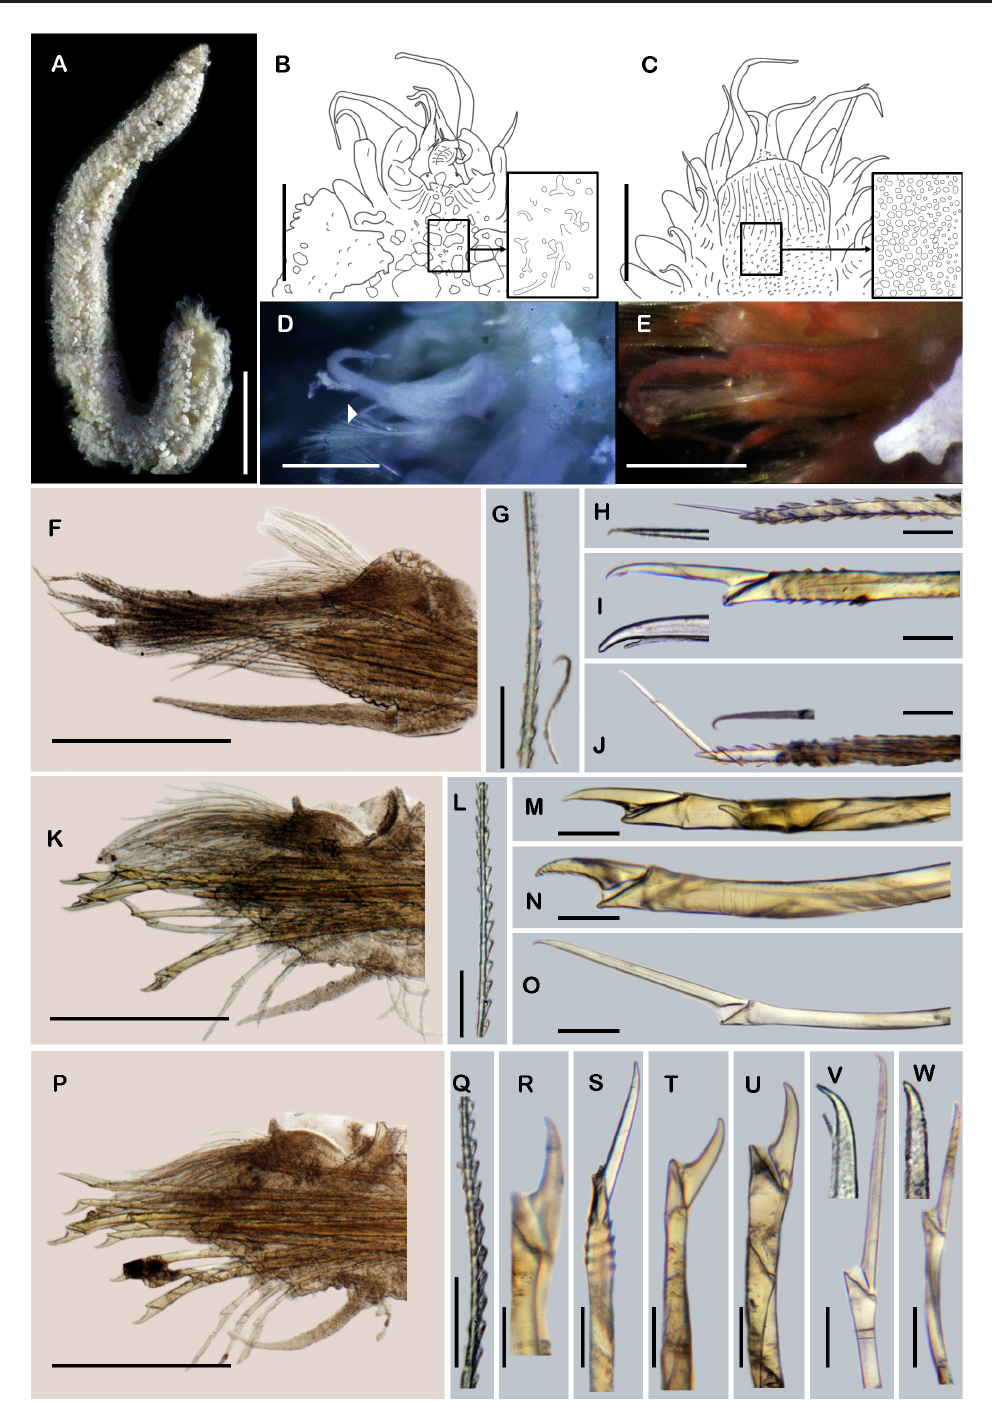
Fig. 21. Pelogenia salazarvallejoi sp. nov., holotype (UF 2757). A . Complete worm, dorsal view. B . Anterior end, dorsal view (insert: dorsal papillae). C . Anterior end, ventral view (insert: ventral papillae). D . Detail of median antenna ceratophore, arrowhead indicates lateral antenna. E . Left cirrus from segment III. F . Right parapodium from segment II. G . Notochaeta from same. H . Unit A. I . Unit B. J . Units C and D. K . Right parapodium from segment III. L . Notochaeta from same. M . Unit A. N . Unit B. O . Units C and D. P . Right parapodium from segment 27. Q . Notochaeta from same. R . Unit A. S . Unit B. T . Unit C. U . Subunit 1. V . Subunit 2. W . Unit D. Scale bars: A = 5 mm; B–C = 1 mm; D–F, K, P = 500 μm; G, L, Q = 40 μm; H–J, M–O, R–W =